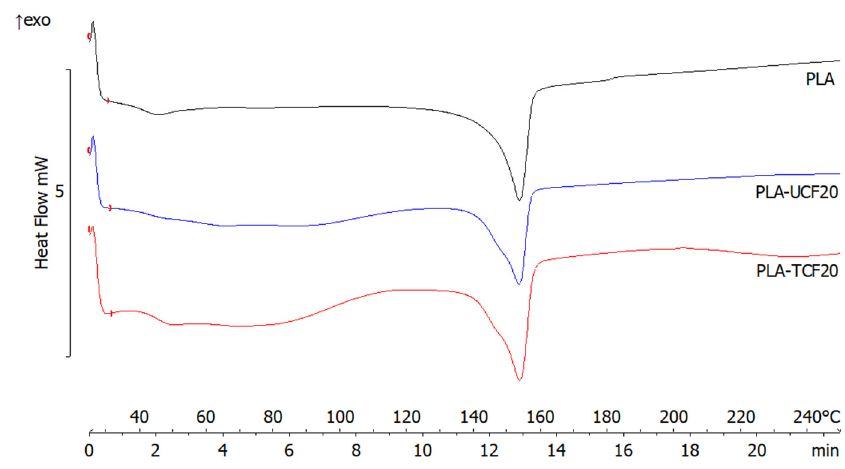
Figure 8. DSC curves of films with and without CF treatment. From the DMA analysis, the glass transition temperatures (Tg) of the composites were evaluated using the tan δ peak temperature. It was found that both the fiber content as well as fiber treatment had an effect on the Tg, as seen in Figure 9.